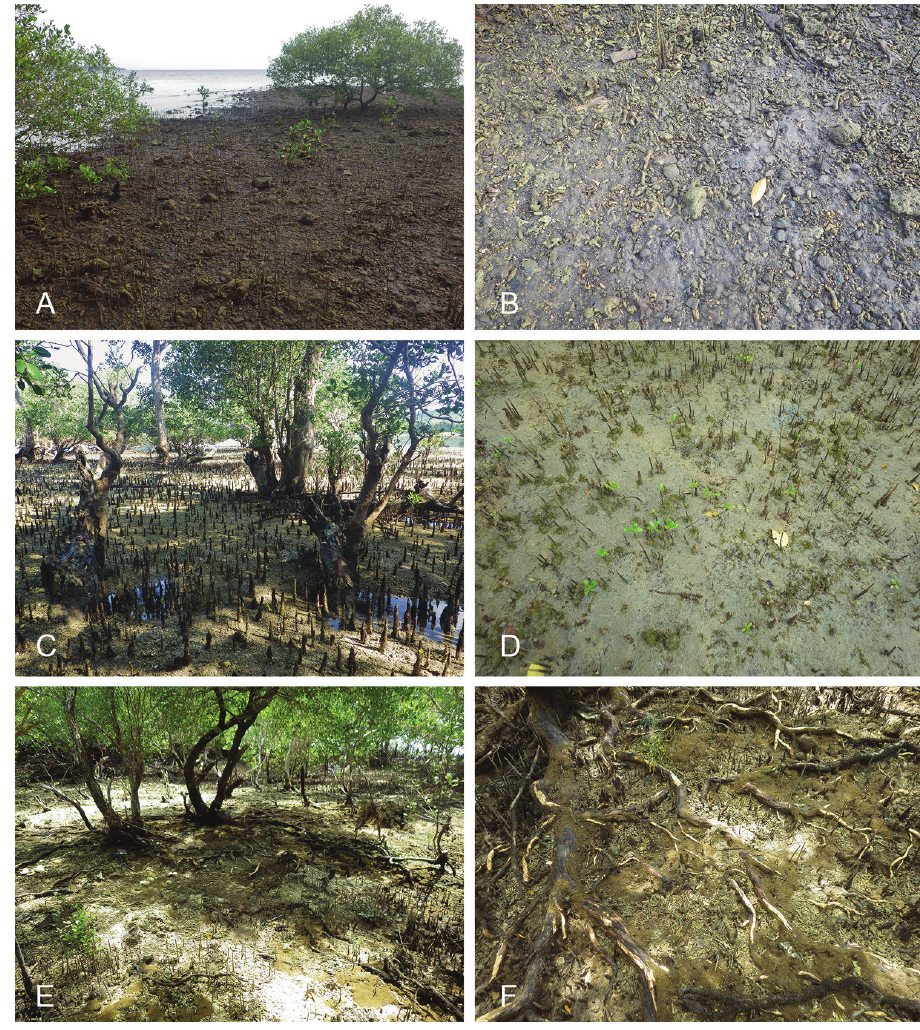
Figure 34. Mangrove habitats, Wallaconchis ater . A–B Indonesia, Bali, Pemuteran, Labuhan Lalang Harbor, coral rubble, rocks and a few Avicennia (st 157) C–D Indonesia, Lombok, Don Don, old Avi- cennia forest, with coral rubble (st 149) E–F Philippines, Bohol, Mabini, open Avicennia and Sonneratia mangrove with sand and coral rubble (st